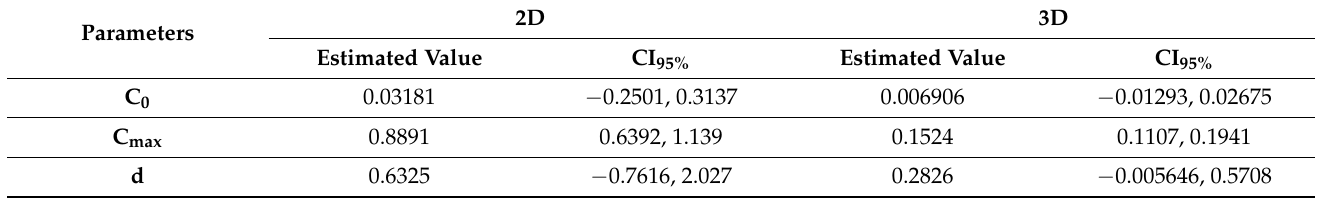
Table A3. Estimated values of the logistic growth model parameters with confidence intervals (CI 95% ).